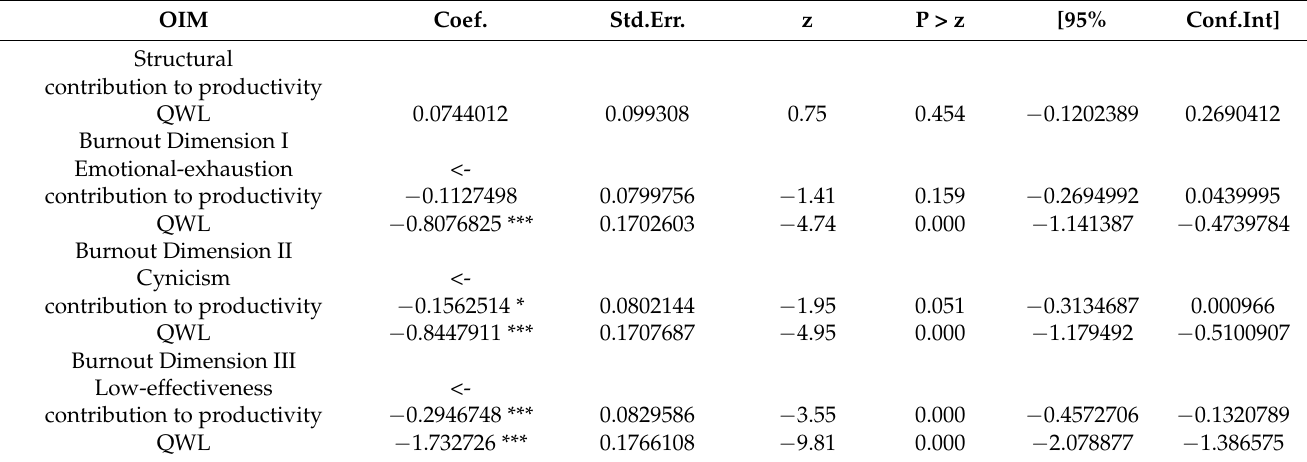
Table 3. Model 1: Direct effects.